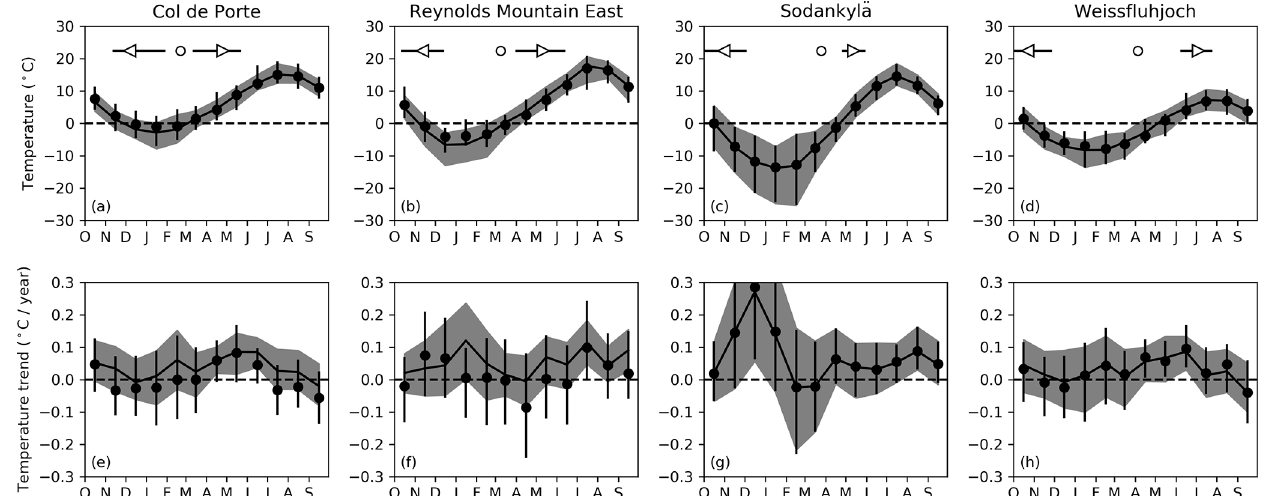
Figure 1. (a–d) Monthly-mean temperatures calculated from measurements at the sites (filled circles) and the driving data (lines). Vertical bars for measurements and grey bands for driving data show ranges between the warmest and coolest months from October 1980 to September 2010. Triangles and horizontal bars show averages and ranges of observed start ( (cid:67) ) and end ( (cid:66) ) dates of continuous seasonal snow cover. Open circles show average dates of maximum snow depth. (e–h) Temperature trends for each month, calculated by the Theil–Sen method (Sen, 1968). Vertical bars for measurements and grey bands for driving data show 95% confidence